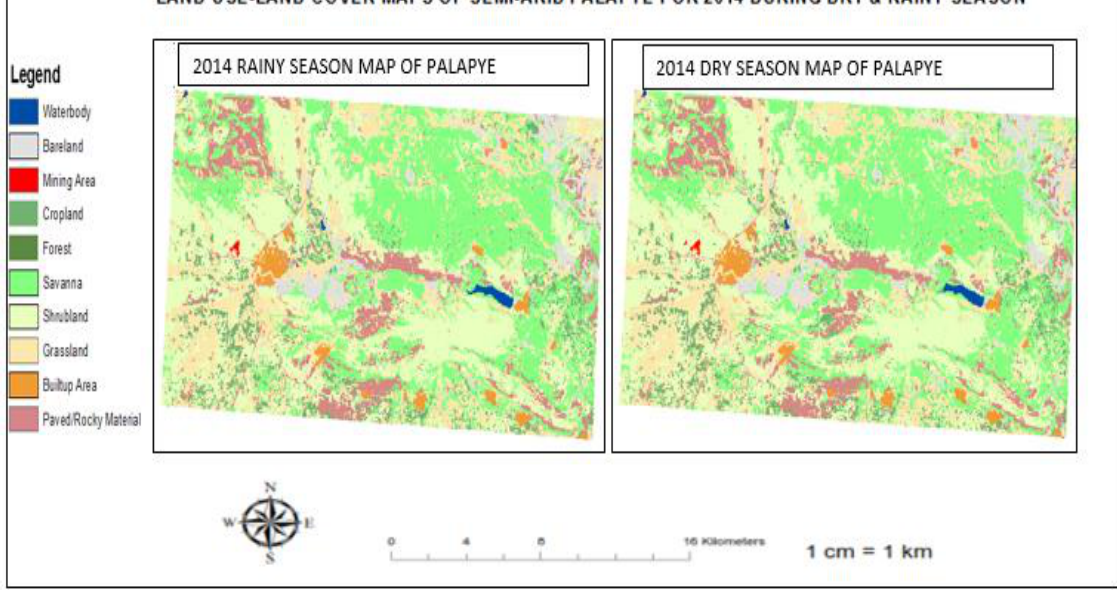
Figure 2: Seasonal land use-land cover maps of semi-arid Palapye for 2014 dry and rainy